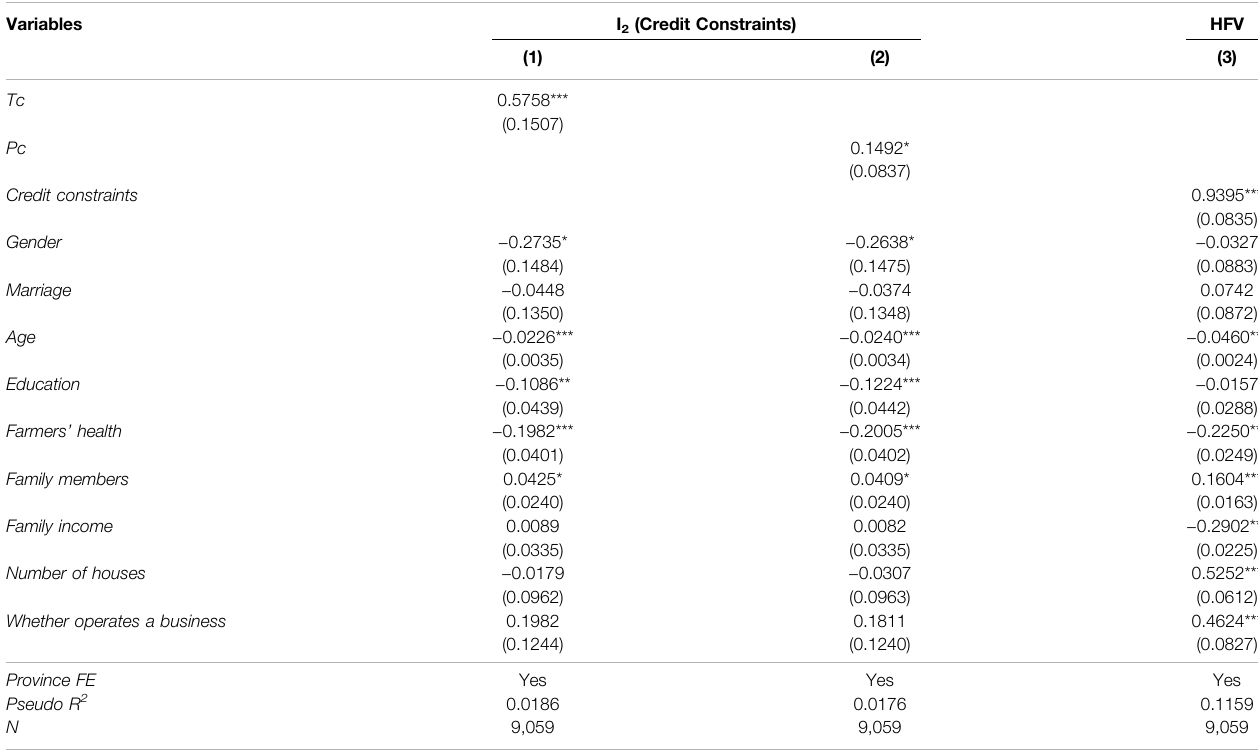
TABLE 6 | Mechanism of credit constraints.